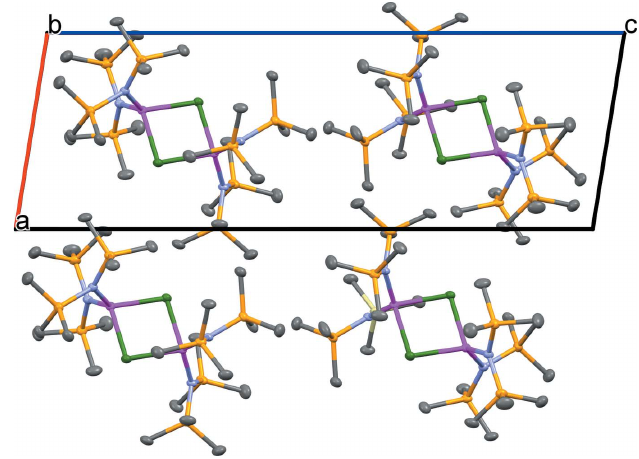
Figure 2 The crystal packing of the title compound seen down the b axis, showing four molecules, three of which are related to the unique one via inversion centres at ( 1 , 1 , 1 ) and (0, 1 , 1 ). The packing is essentially based on van der 2 2 2 2 2 Waals interactions only.